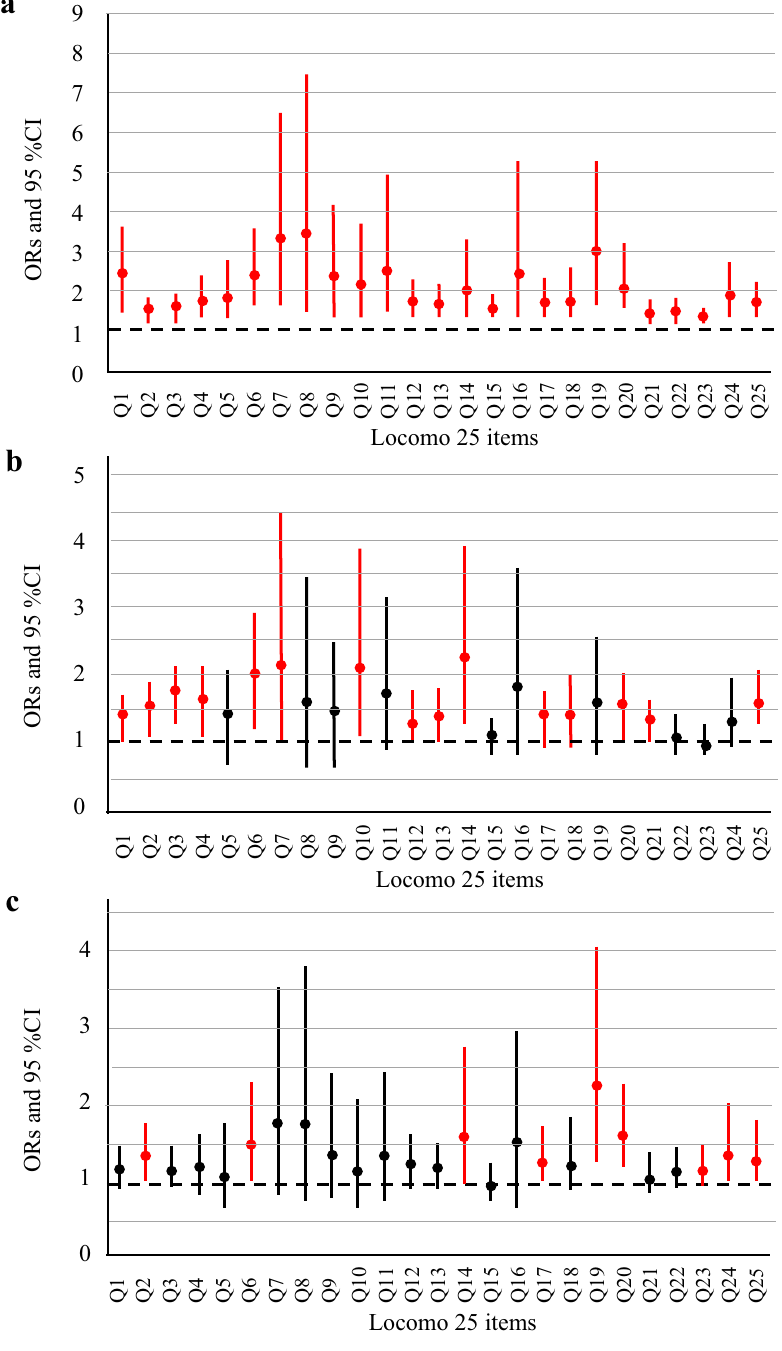
Figure 1. Odds ratios of Locomo 25 items for oral dysfunctions. Red color bars indicate a significant difference on univariate logistic regression analysis. ( a ) Odds ratios for “decline in masticatory function”. ( b ) Odds ratios for “difficulty swallowing”. ( c ) Odds ratios for “dry mouth”. OR, odds ratio; CI, confidence